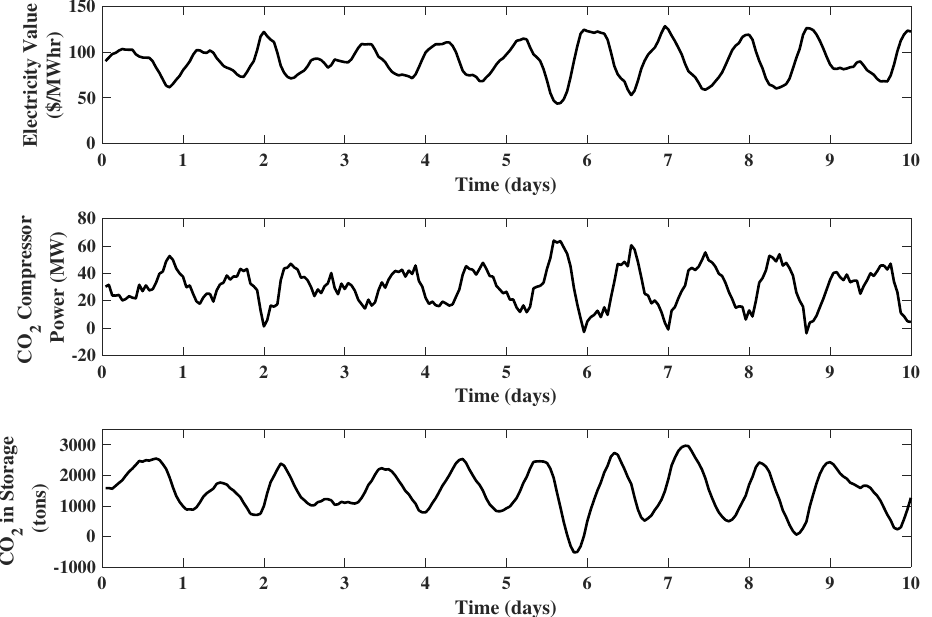
Figure 19. Value of electricity and the resulting CO 2 compressor power consumption dispatch for the = ( $20/MW h ) 2 and C = 100 $/ton MeOH with reduced compressors case of Σ C M e